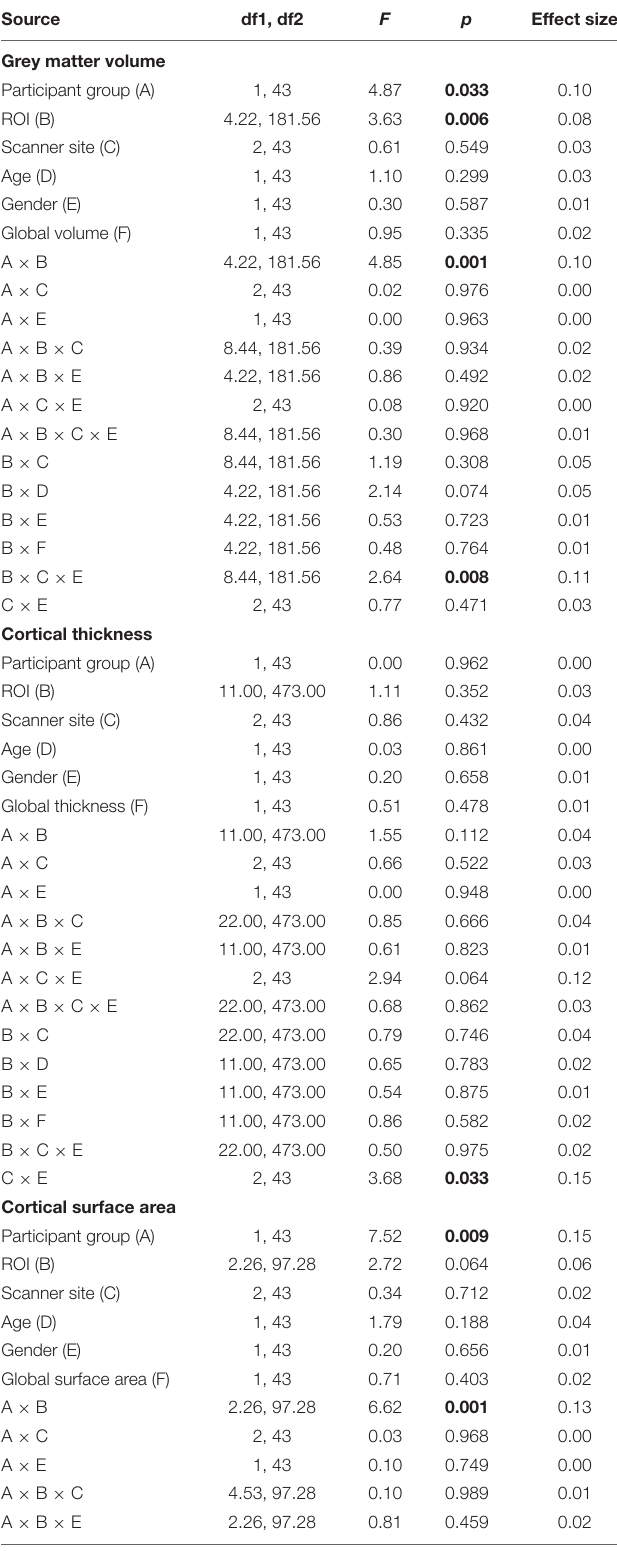
TABLE 2 | Results of analysis of covariance to assess effects of possible confounds age, scanner site, gender and global metrics. Source df1,